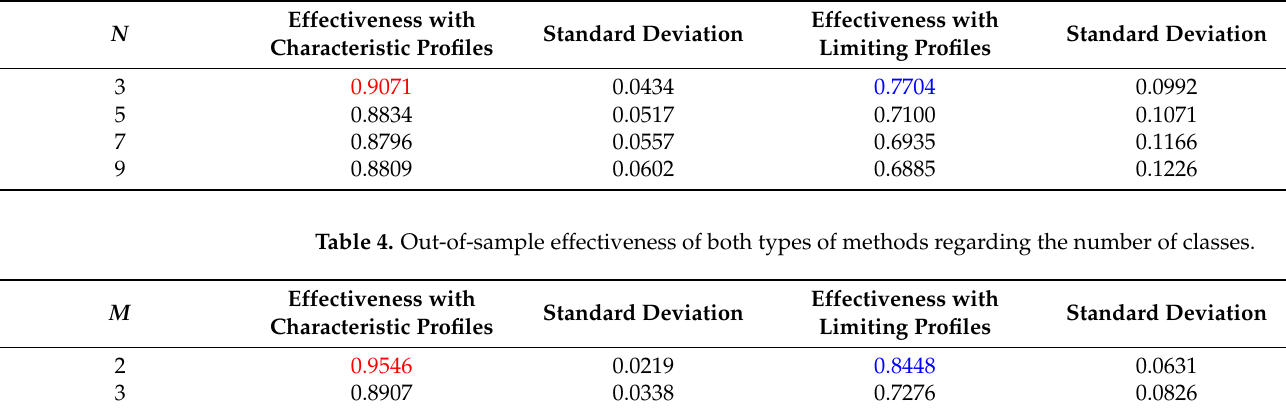
Table 3. Out-of-sample effectiveness of both types of methods regarding the number of criteria.